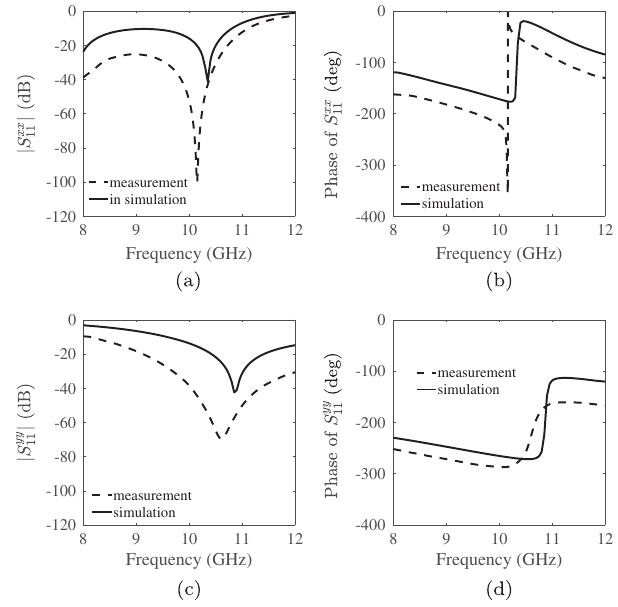
FIG. 21. Simulated and measured reflection coefficient entries for the QWP. (a) Amplitude and (b) phase of the reflection coefficients for x polarization. (c) Amplitude and (d) phase of the reflection coefficients for y